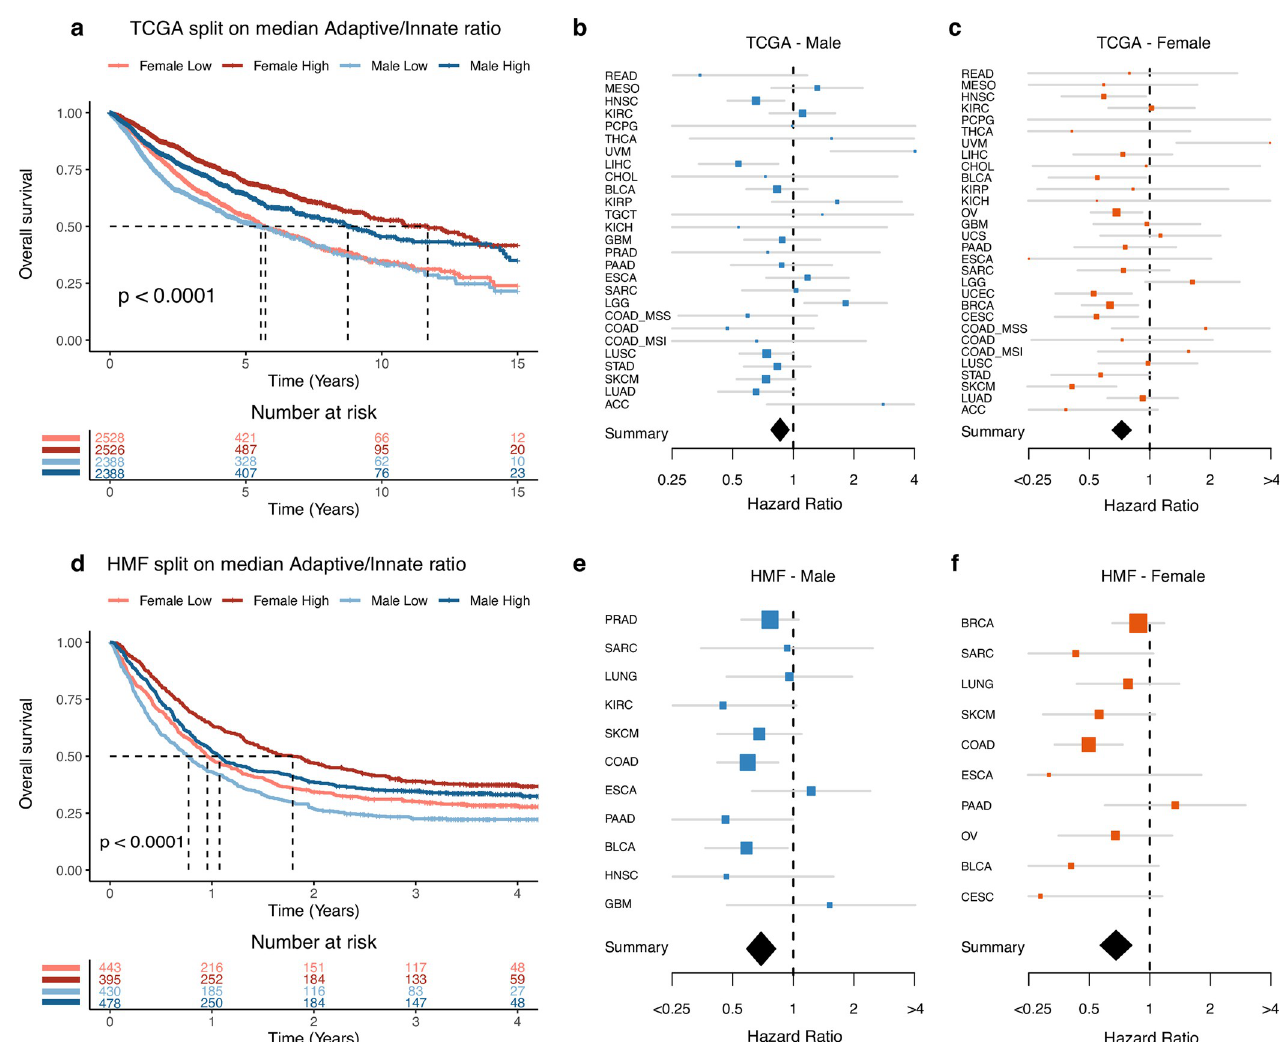
Fig 2. Survival based on A/I ratio. a) A Kaplan-Meier curve showing the 15-year overall survival for patients in the TCGA cohort, the patients are divided by gender and by median A/I ratio. b) A forest plot showing the univariate cox proportional hazard regression for the A/I ratio against overall survival, for the male patients in each of the TCGA cancer types. The diamond represents the hazard ratio from the meta-analysis across all cancer types. c) A forest plot showing the univariate cox proportional hazard regression for the A/I ratio against overall survival, for the female patients in each of the TCGA cancer types. The diamond represents the hazard ratio from the meta-analysis across all cancer types. d) A Kaplan-Meier curve showing the 4-year overall survival for metastatic cancer patients in the HMF cohort, the patients are divided by gender and by median A/I ratio. e) A forest plot showing the univariate cox proportional hazard regression for the A/I ratio against overall survival, for the male patients in each of the cancer types in the HMF cohort. The diamond represents the hazard ratio from the meta-analysis across all cancer types. f) A forest plot showing the univariate cox proportional hazard regression for the A/I ratio against overall survival, for the female patients in each of the cancer types in the HMF cohort. The diamond represents the hazard ratio from the meta- analysis across all cancer types. above the female median A/I ratio, and females with an A/I ratio above median, for each can-